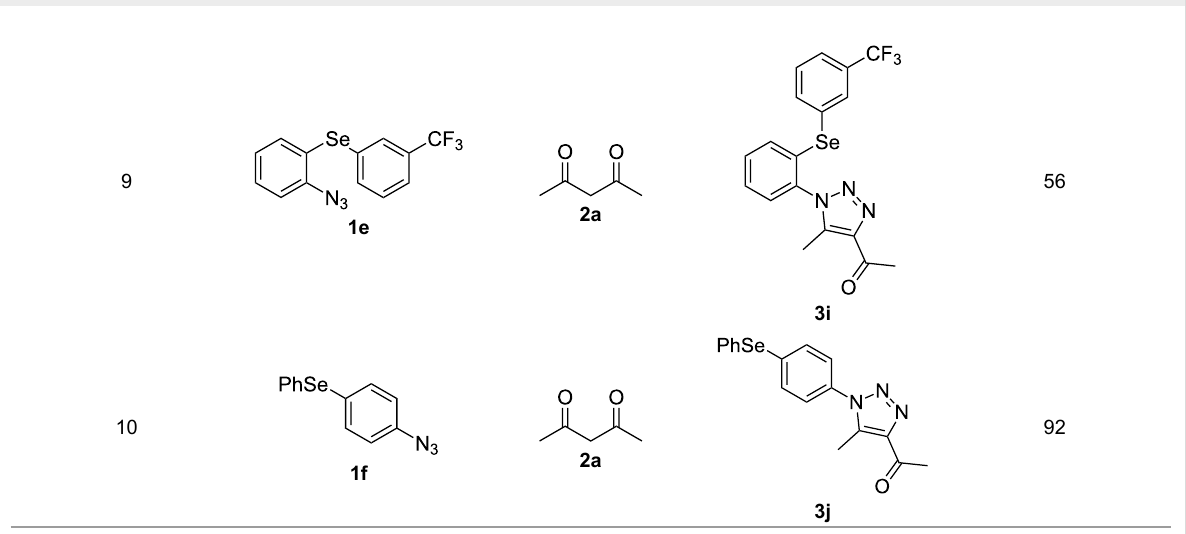
Table 2: Scope of substrates: Variation of the aryl azidophenyl selenides 1 and 1,3-diketones 2 . a